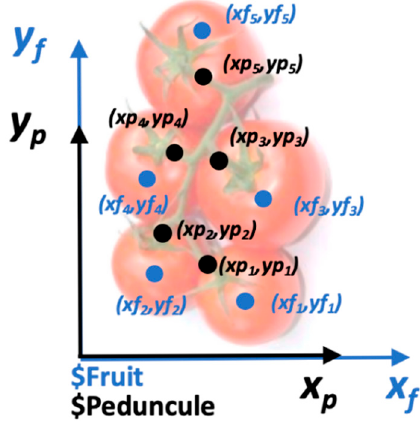
Figure 2. Automatic 2D detection and location of the ripe tomato elements.